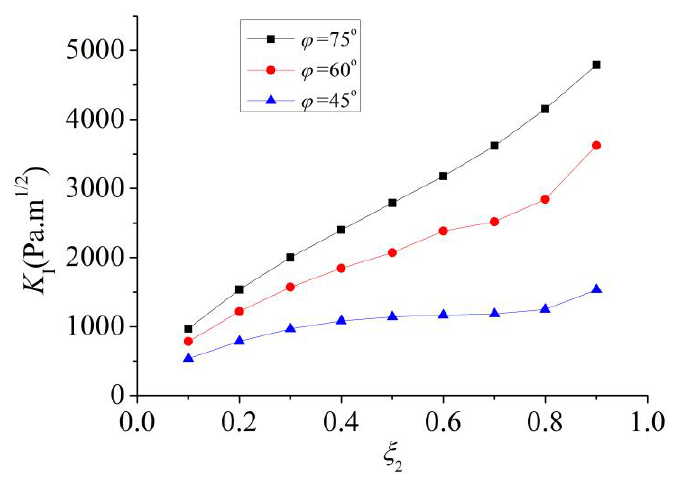
Figure 25. K I − ξ 2 for different crack inclination angles.